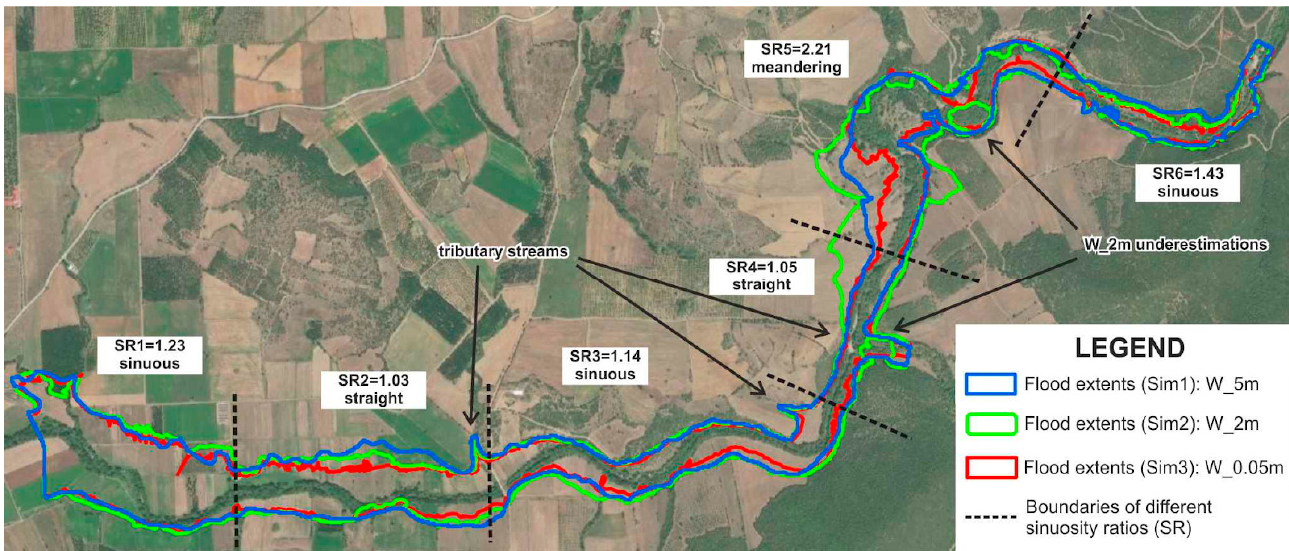
Figure 9. Flood extents of the three hydraulic simulations (Sim 1 = W_5 m; Sim 2 = W_2 m; Sim 3 = W_0.05 m) projected on the same map (separate maps in SM16, SM19, SM21). Table 3. Area differences (km 2 ) of flood inundated regions between Sim 1 and Sim 3 (W_5 m–W_0.05 m) and Sim 2 and Sim 3 (W_2 m–W_0.05 m) as overall error, overestimations, and